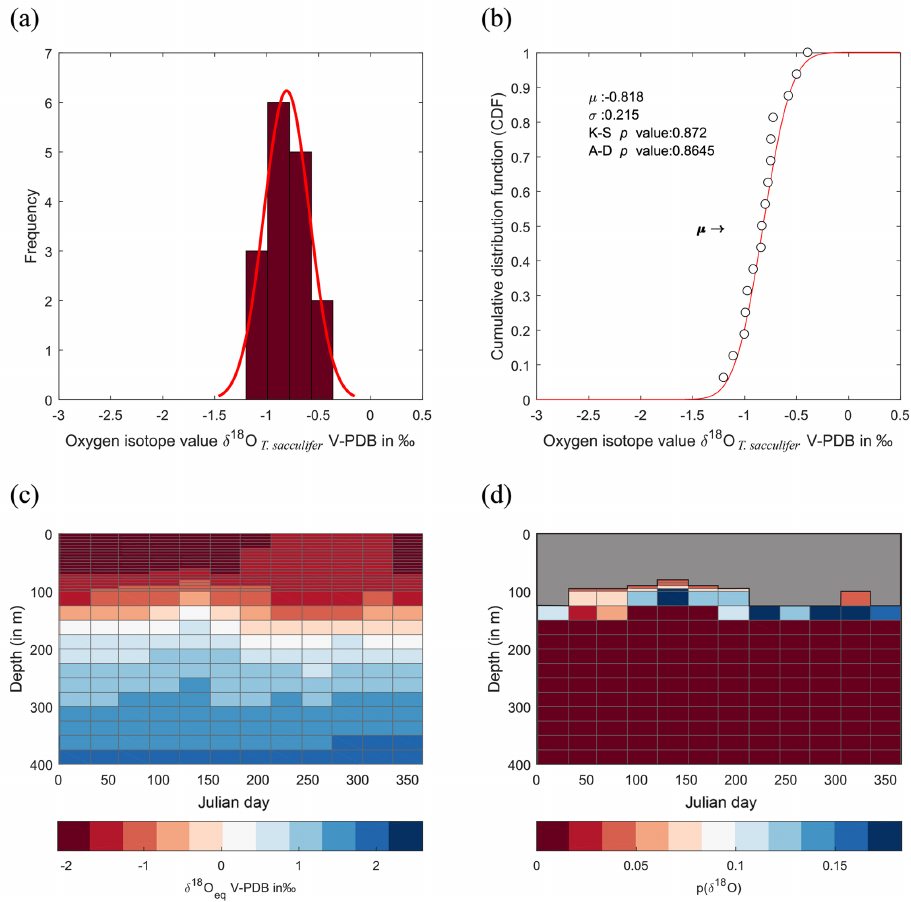
Figure 9. Calculated δ 18 O probability ( p(δ 18 O ) ). As per Fig. 8, with individual isotope values, CDF distribution, WOA13 δ 18 O eq and resultant p(δ 18 O ) but with T. sacculifer